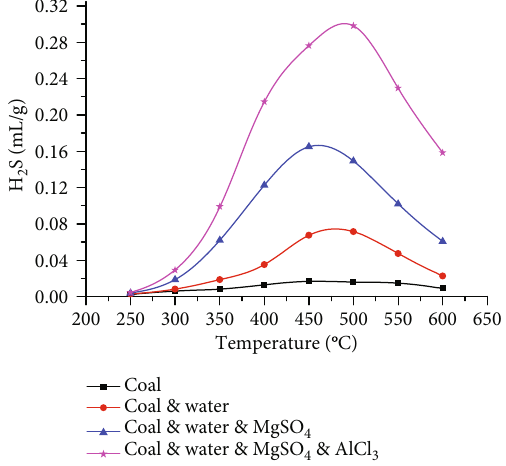
Figure 5: Variation characteristics of heavy hydrocarbon.